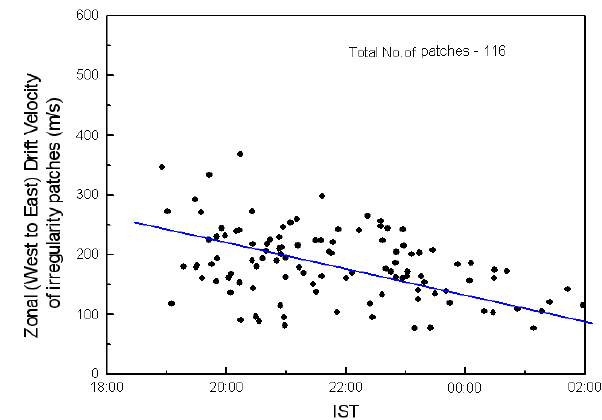
Fig. 5. Local time variation of zonal drift velocities of PBI irregu-